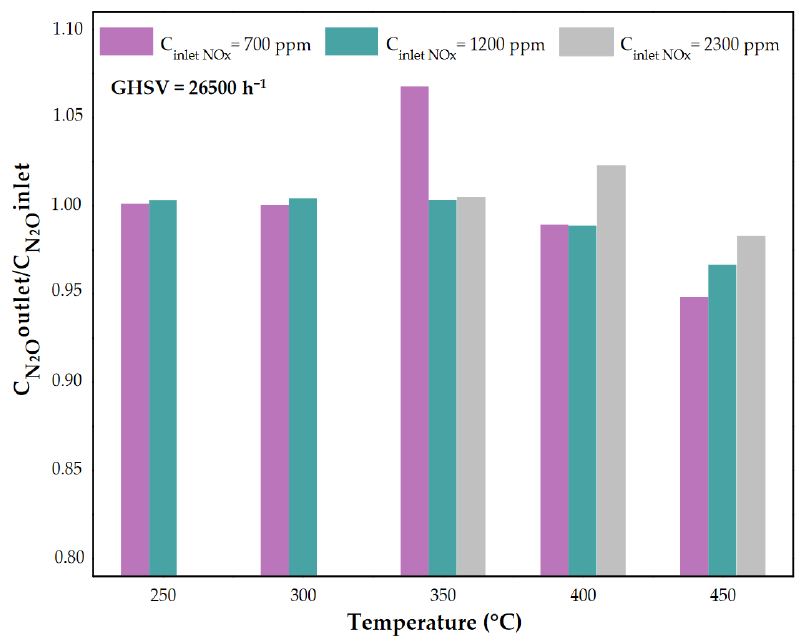
Figure 9. The ratio of N 2 O concentration downstream of the catalytic bed and N 2 O inlet concentration as a function of the temperature for Fe-Clin-I at GHSV = 26,500 h − 1 , C inlet (NO x ) = 700, 1500, 2300 ppm.